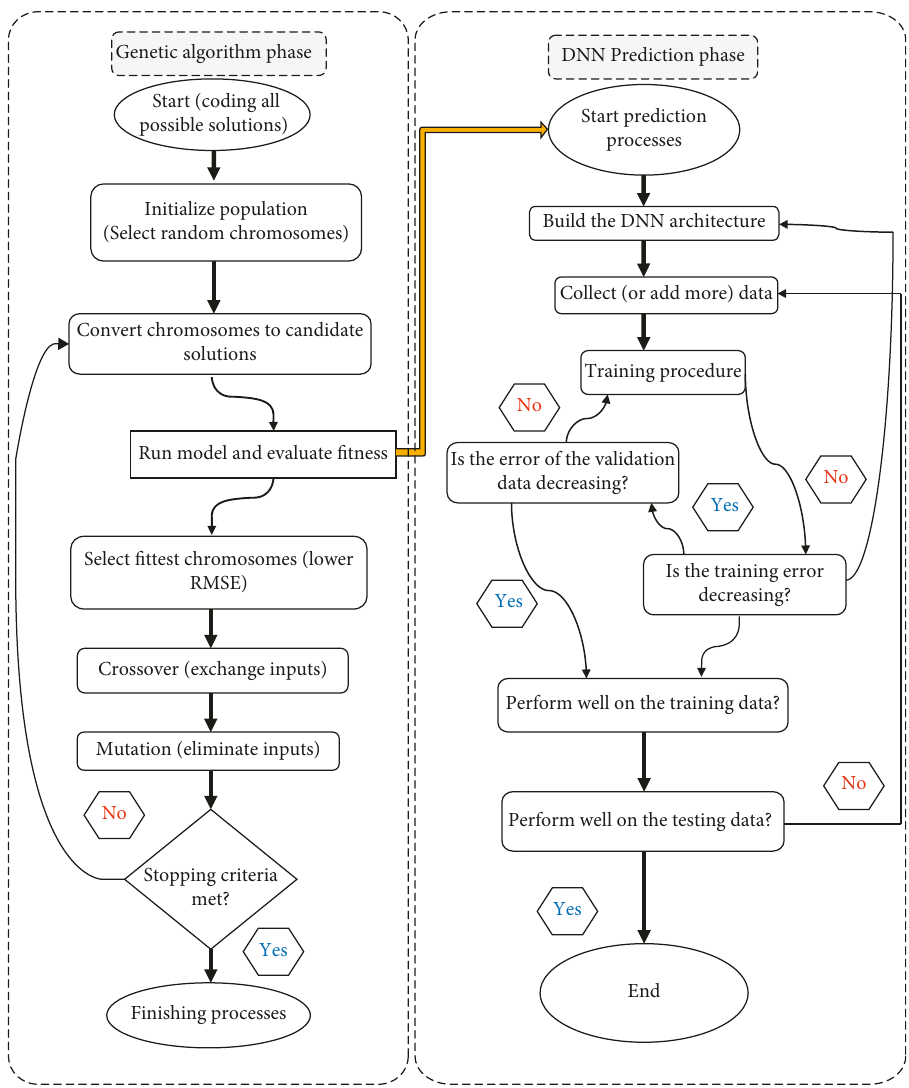
Figure 3: The proposed hybrid genetic algorithm deep neural network (GA-DNN) predictive